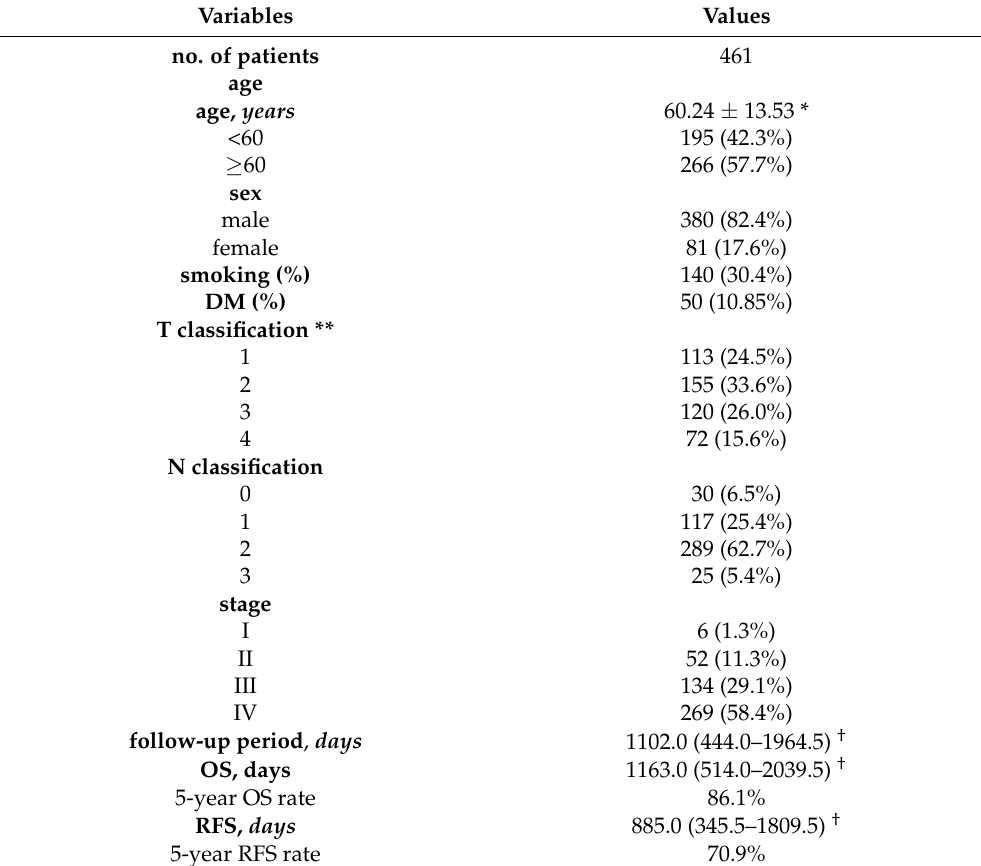
Table 1. Patients’ characteristics.